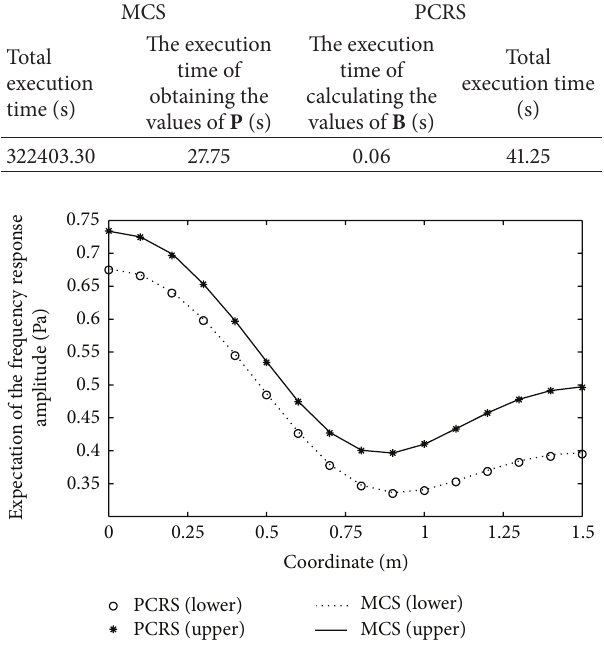
Figure 2: The lower and upper bounds of expectation of the frequency response amplitude at nodes along the line of 𝑦 = 0.5 m calculated by PCRS and MCS.